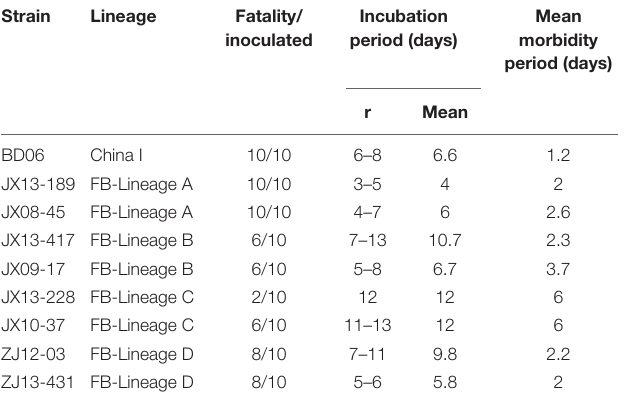
TABLE 2 | Morbidity, incubation, and morbidity period of mice following intramuscular inoculation with each strain. Strain Lineage Fatality/ inoculated